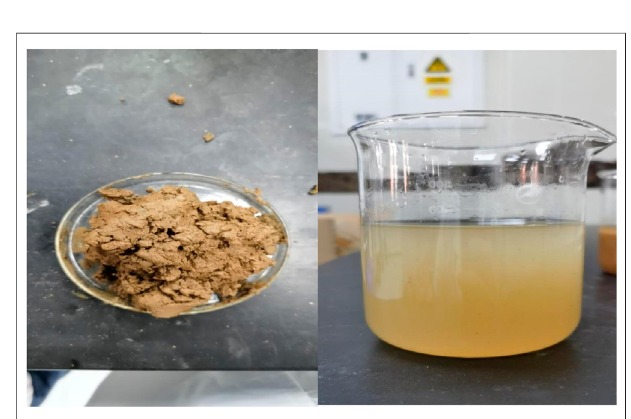
FIGURE 8 | Solid and liquid phases separated by fi eld